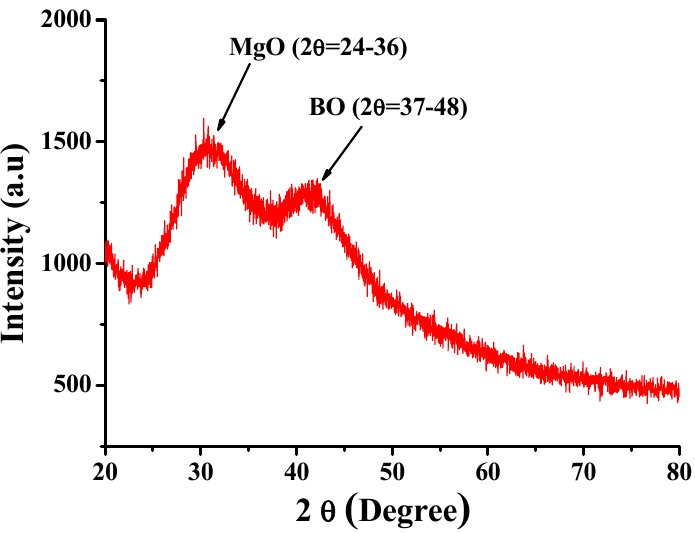
Figure 1. Typical XRD spectrum of MgB 4 O 7 :Zn glass.